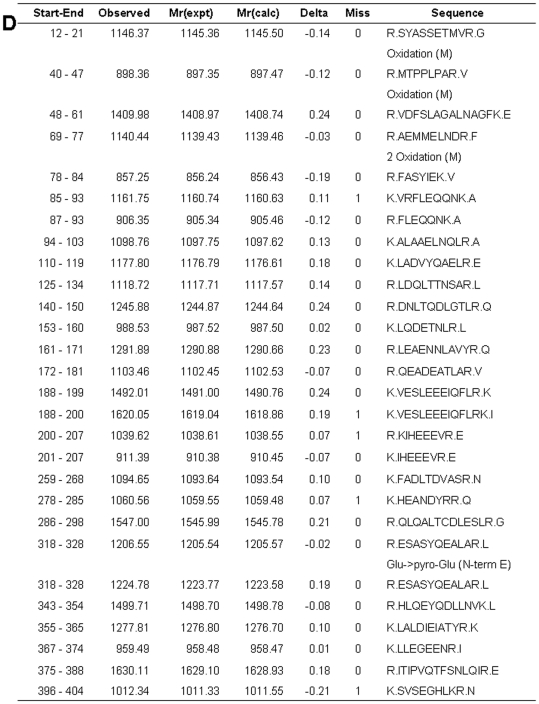
Peptide matches of spot 8 with GFAP.List of the monoisotopic masses of some of the peptides identified showing their position in the sequence of GFAP.